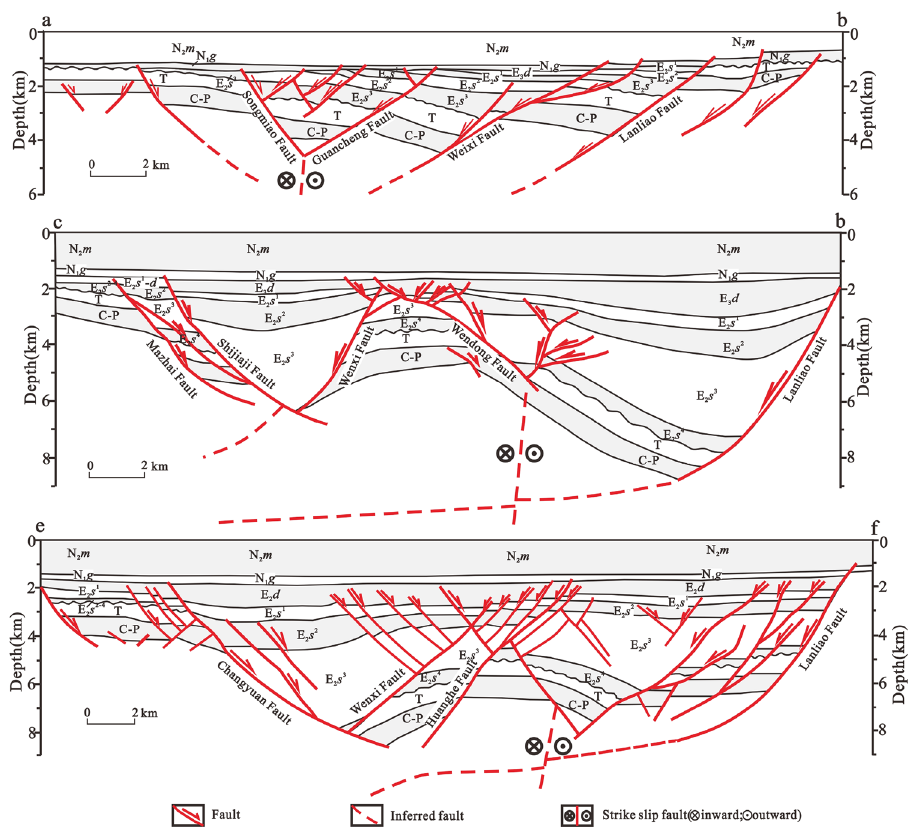
Figure 2. Structural profile of the Dongpu Depression. N 2 m = Pliocene Minghuazhen Formation;